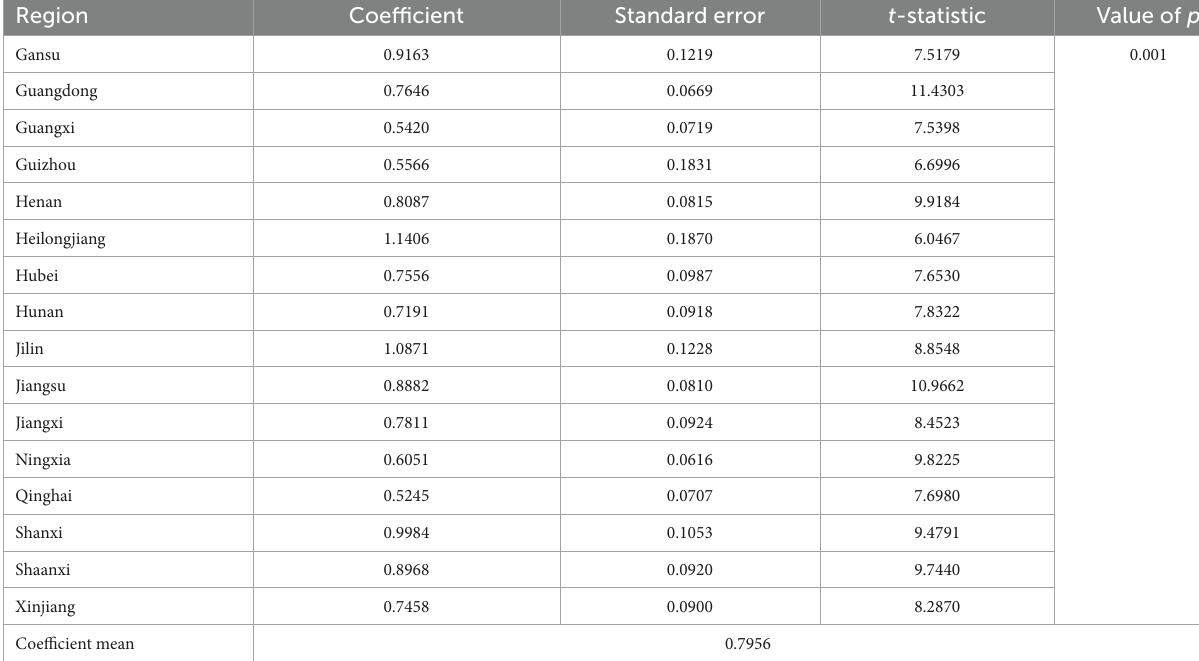
TABLE 9 Results of the regression coefficients for Class II regions.